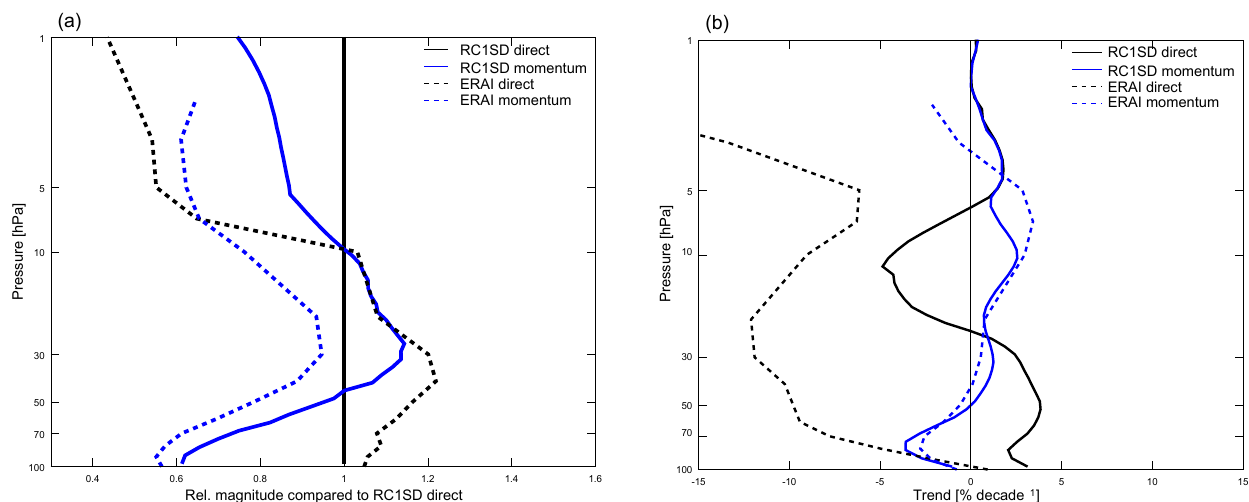
Figure 4. (a) Annual mean profiles of tropical upwelling (30 ◦ S–30 ◦ N), calculated with the direct (black) and momentum-based (blue) esti- mates for the simulations EMAC-RC1SD (solid) and ERA-Interim (dashed). Note that tropical upwelling is plotted as a relative contribution to the total direct upwelling of EMAC-RC1SD. (b) Trends (1990–2011) for the profiles of tropical upwelling (relative to the climatological direct estimate of tropical upwelling in EMAC-RC1SD), again calculated with direct and momentum-based estimates and for EMAC-RC1 and ERA-Interim. The trend is given in % per